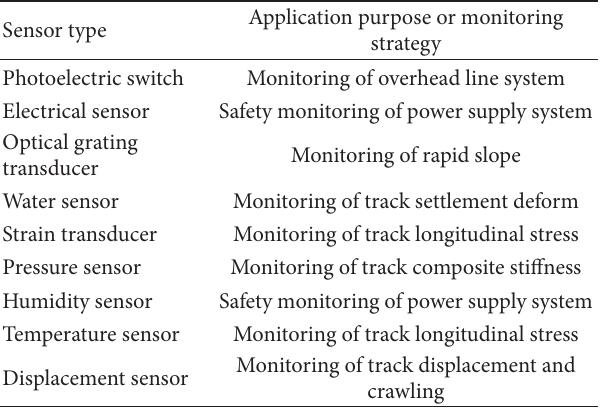
Table 1: Common types of sensors used in IHM-WSNs.